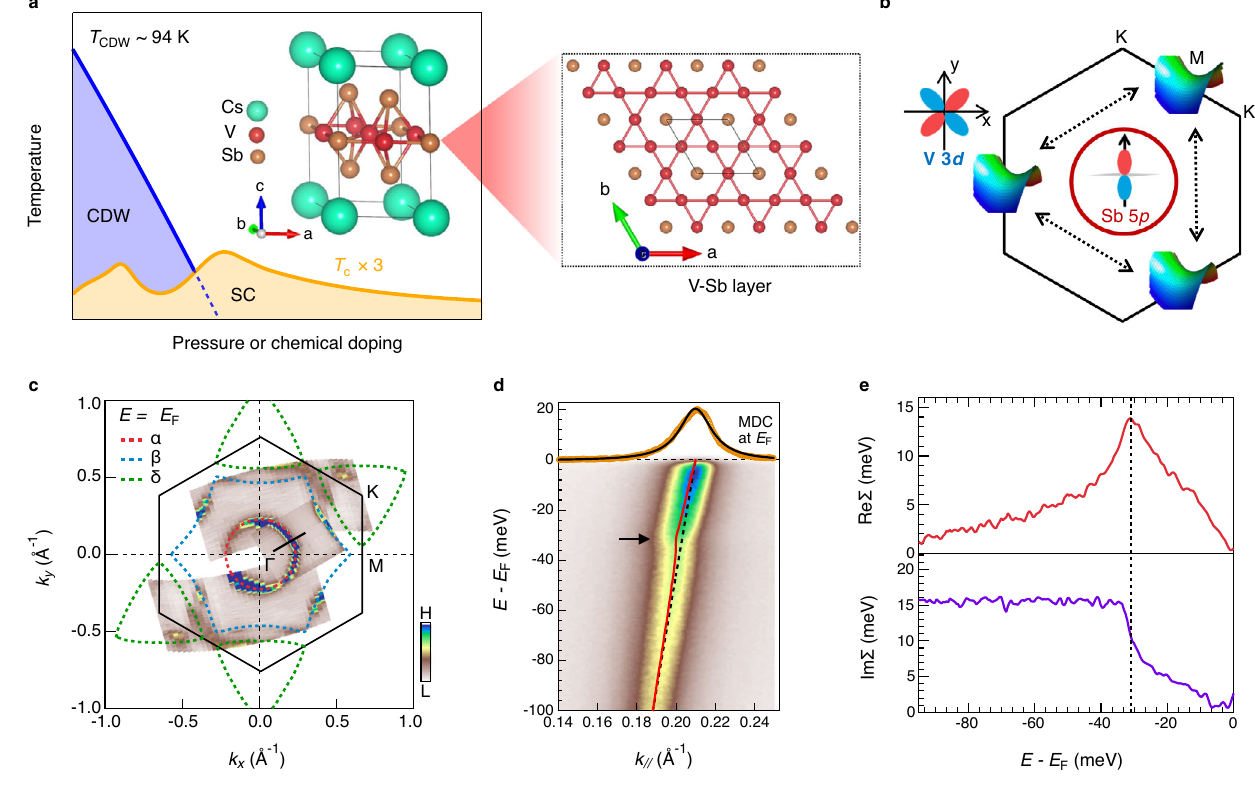
Fig. 1 | EPC-induced electronic kink in CsV 3 Sb 5 . a Schematic temperature versus pressure/dopingphasediagram.TheinsetshowsthecrystalstructureofCsV 3 Sb 5 .A topviewoftheV-Sblayeriszoomedinontherightpanel. b SchematicofvanHove singularities atthe M point oftheBrillouinzone boundarywhich areconnectedby three nesting wavevectors. The von Hove singularities has mainly V 3 d orbital characters ( d x 2 (cid:2) y 2 and d yz ). The circular electronic pocket at Γ point has mainly Sb 5 p z orbitalcharacter. c FSmappingwithintensityintegratedwithin E F ±5meV.The FSsheetin k y <0issymmetrizedfromtheonein k y >0andasuperposedFSsheetis